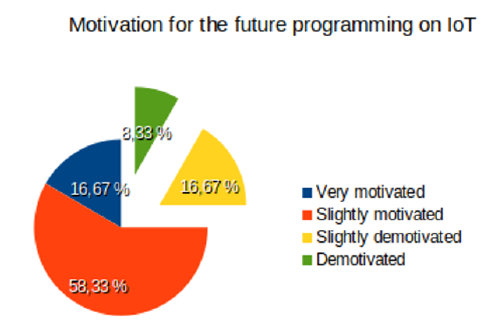
Figure 13. Question related to motivation for future programming on IoT.